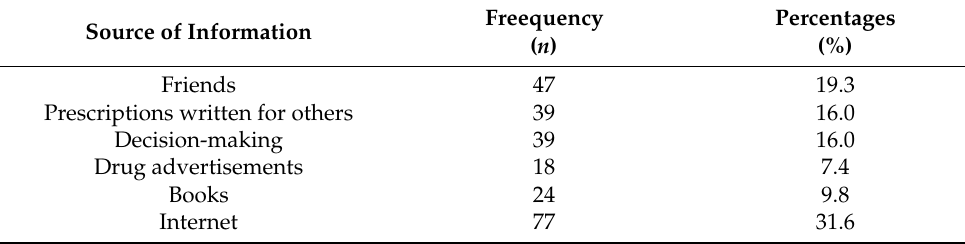
Table 6. Sources of information ( n = 244).